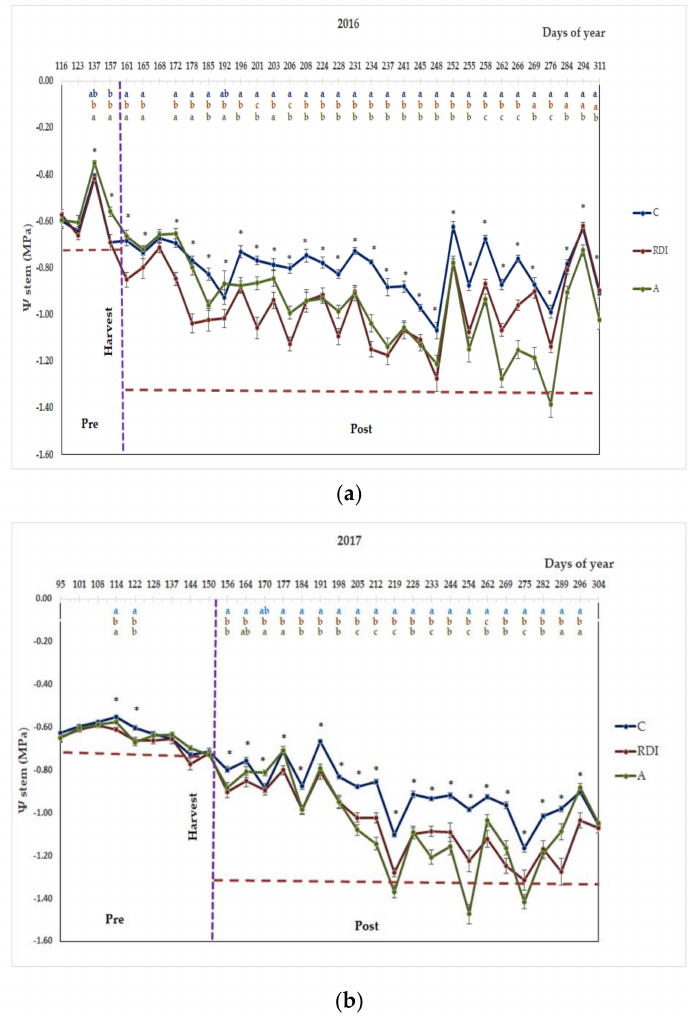
Figure 6. Seasonal variations in midday stem water potential ( Ψ stem ) of ‘Red Beaut’ plum trees in response to di ff erent irrigation treatments during ( a ) 2016 and ( b ) 2017. Each value is the mean of 32 measurements ± standard error. Pre is the period from fruit set to harvest of the current year. Post is the period from harvest to the onset of leaf fall of the current year. The vertical dashed line indicates the moment of harvest. The horizontal dashed line indicates the threshold established for each crop phase. * Indicates significant di ff erences according to Duncan’s multiple range test ( p = 0.05). C is the control treatment and A is the automatic